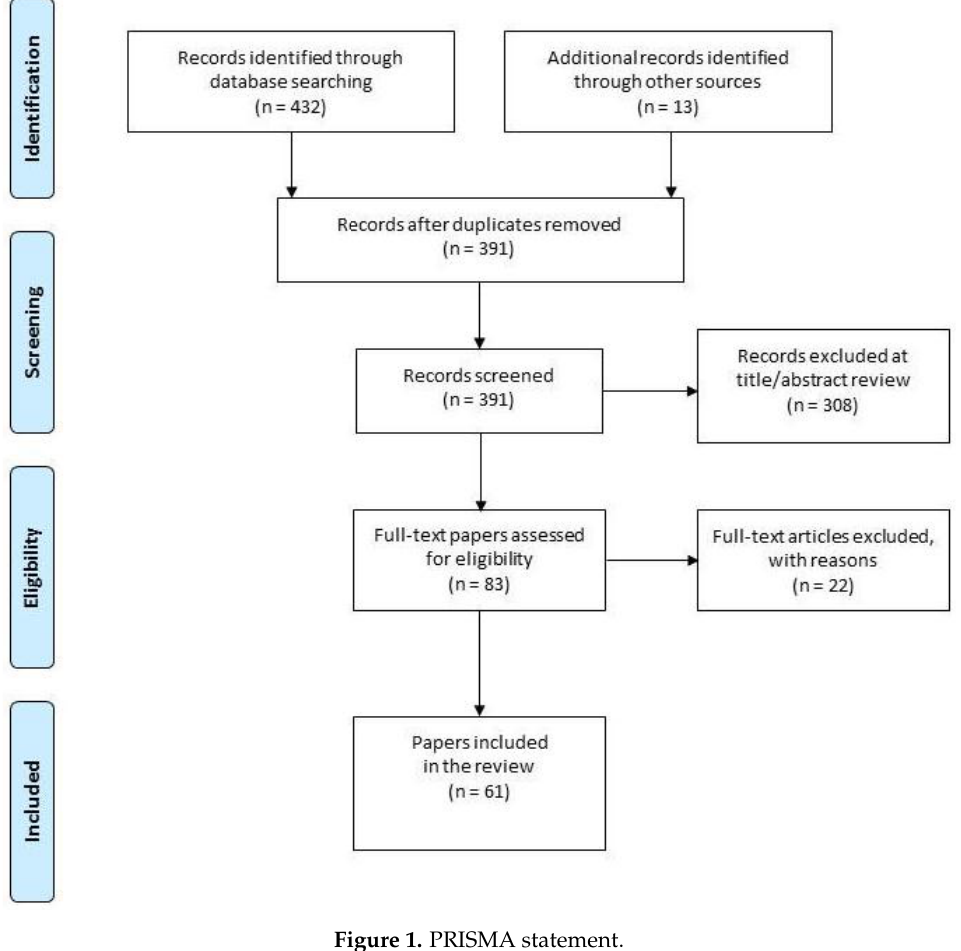
Figure 1. PRISMA Figure 1. PRISMA statement.